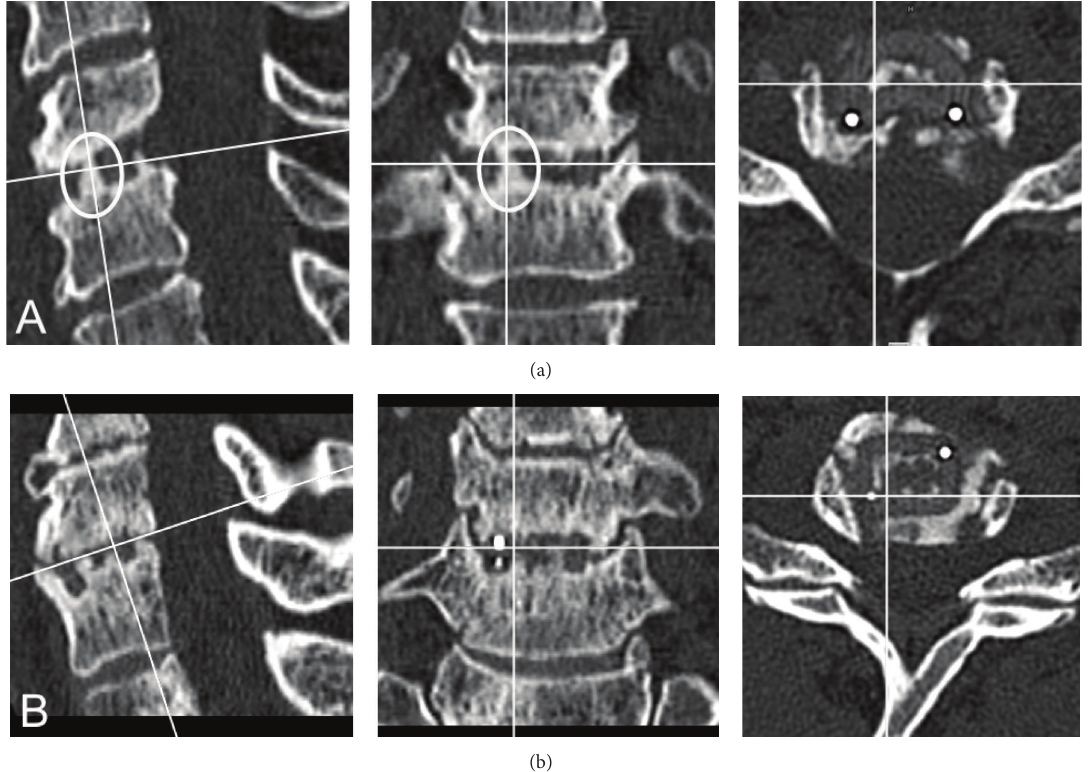
Figure 2: Fusion and nonfusion. Postoperative three-dimensional reconstructed CT scans after ACD with implantation of PEEK cages. (a) A continuous trabecular bone bridge through the cage (encircled) confirmed bony fusion; (b) no bony fusion was assessed due to the lack of continuous trabecular bone bridges.